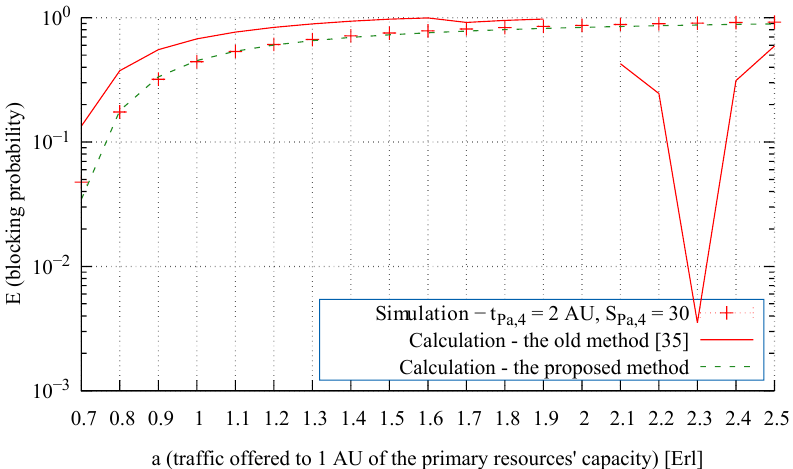
Figure 10. Blocking probability of the Pascal traffic class t Pa,4 = 2 in the secondary resources in System